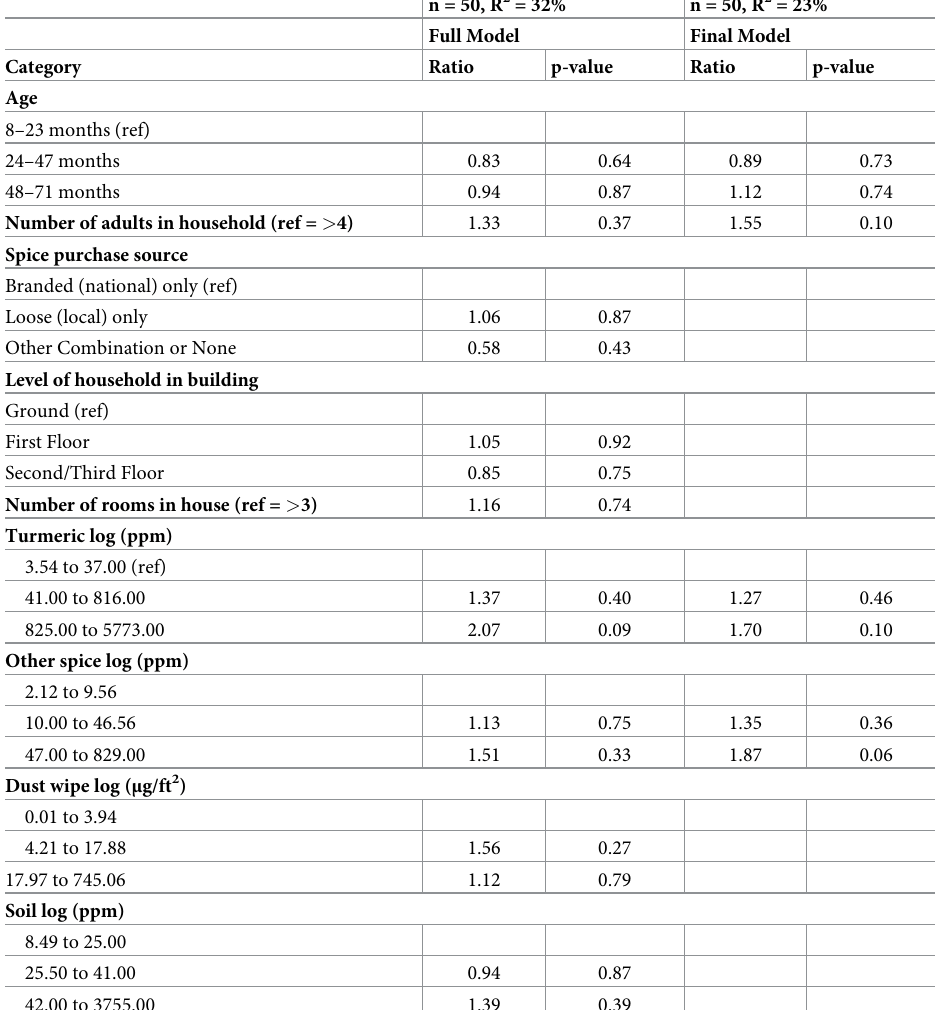
Table 12. Backward models BLLs and variables significant at p < 0.10, categorical age forced into the model with R-Squared Proximal group Patna Bihar,